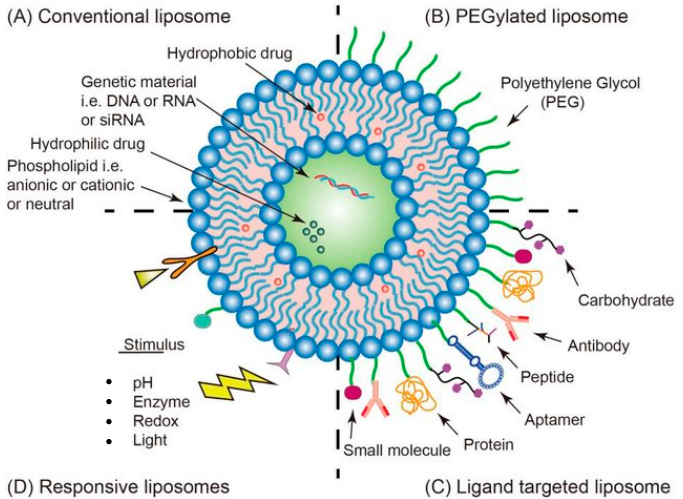
Figure 2. Strategies of functionalized liposome delivery for solid tumor therapy. ( A ) Conventional liposomes can reach tumor tissues through the EPR effect. ( B ) Surface-PEGylated liposomes can increase circulation time. ( C ) Functionalized liposomes modified with appropriate ligands can reach the target site and release the drug. ( D ) Responsive liposomes activate drug release only under specific environmental conditions. Reproduced from ref. [51].